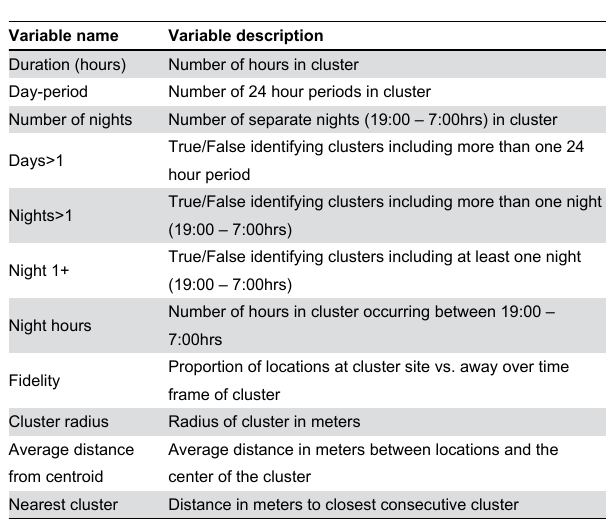
Table 1. Spatial and temporal attributes of clusters examined as potential predictors for cougar